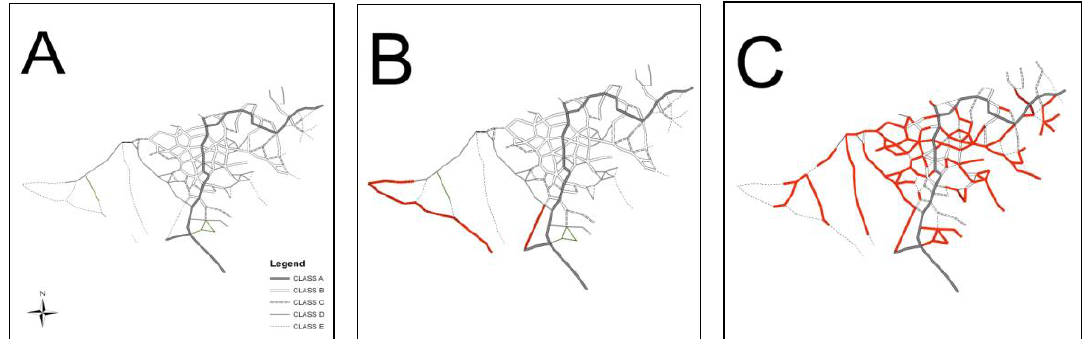
Figure 2. The 52 road segments in Homa Bay used in this research: ( A) Ground truth; (B) Classification by a local taxi driver; and (C) Classification by a teacher without local knowledge. Misclassified road segments in